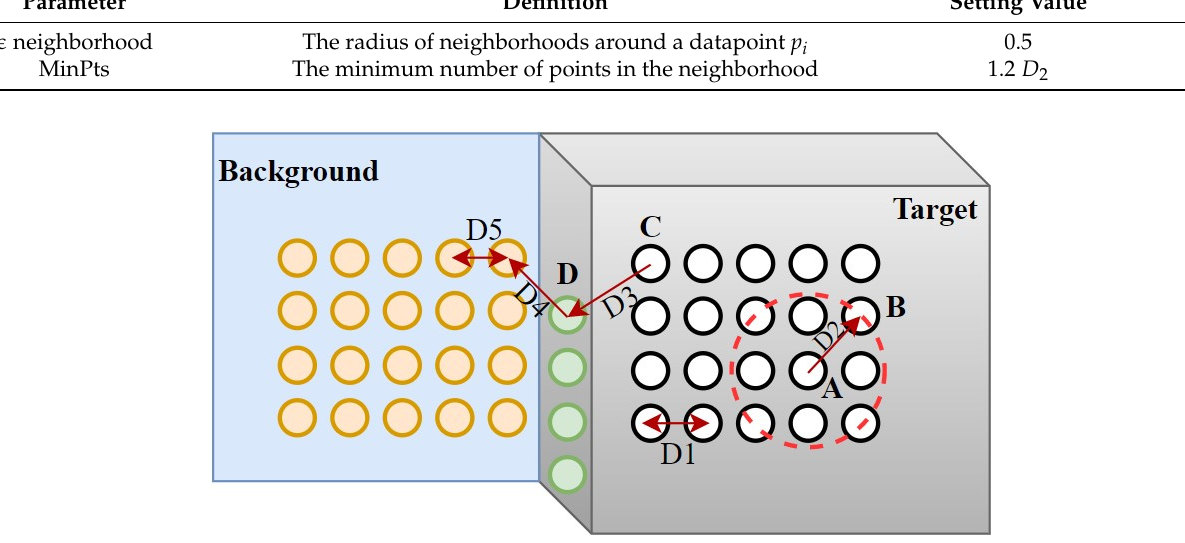
Figure 3. Denoising based on DBSCAN.